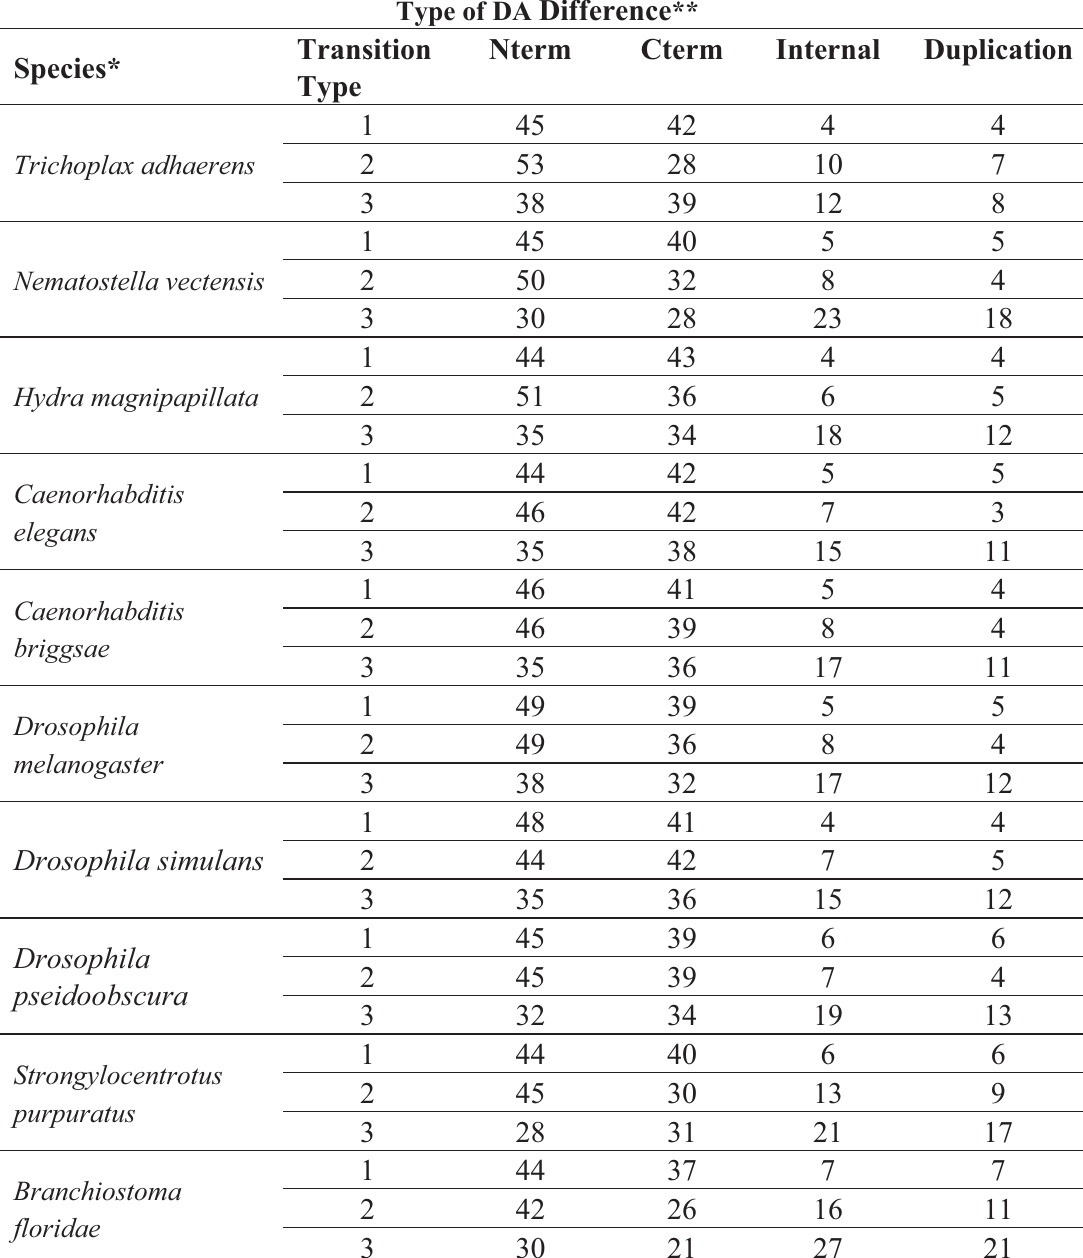
Table S8. Positional distribution of DA differences of paralogous human Swiss-Prot proteins defined through comparison with RefSeq proteomes of various